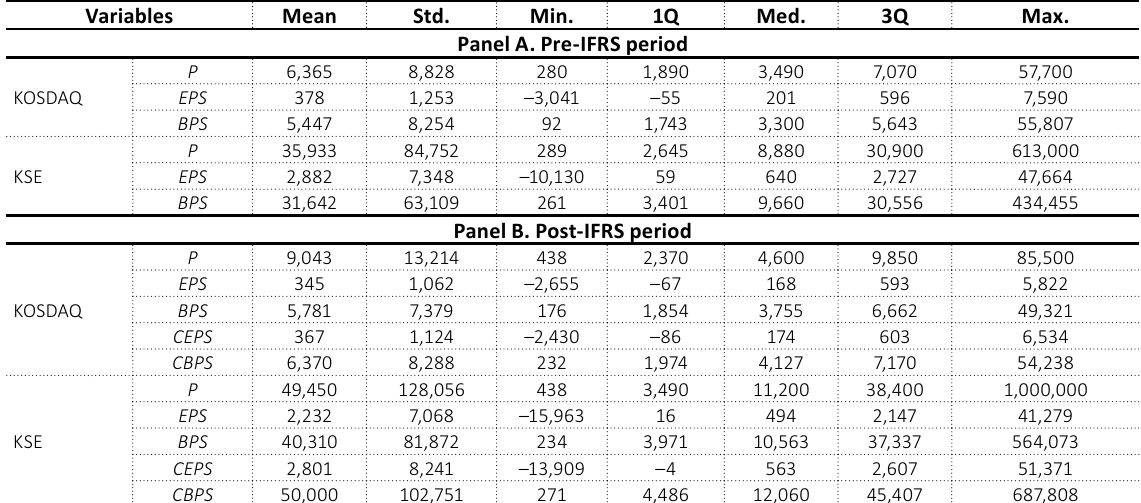
Source: Unit: Korean Won